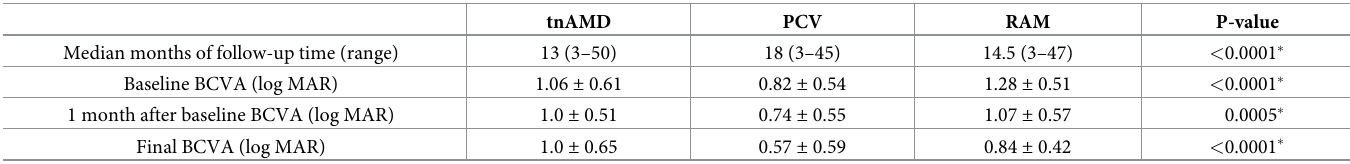
Table 3. The course of best-corrected visual acuity among the tnAMD, PCV, and RAM